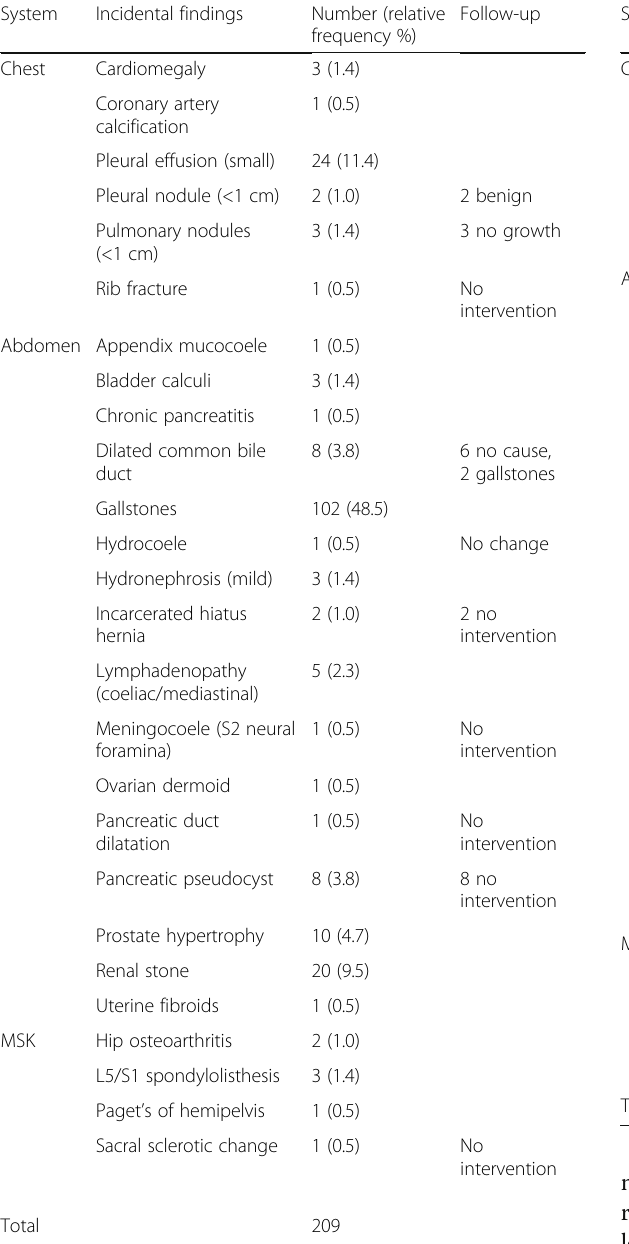
Table 3 Class II extravascular incidental findings according to system area. (MSK denotes